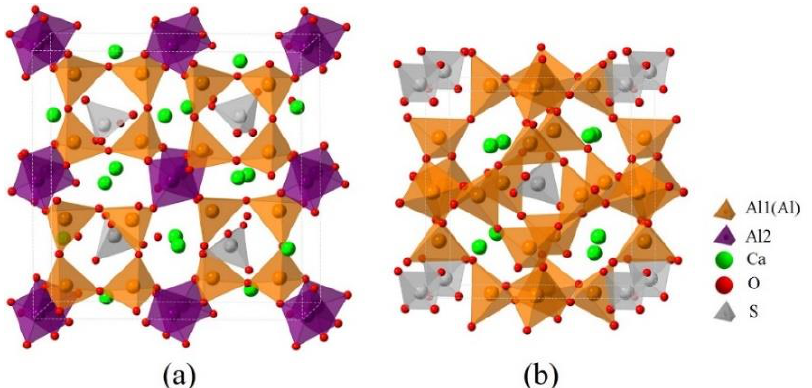
Figure 1. Crystalline structures of ye’elimite: ( a ) orthorhombic (1 1 1) and ( b ) cubic (1 1 1) systems.